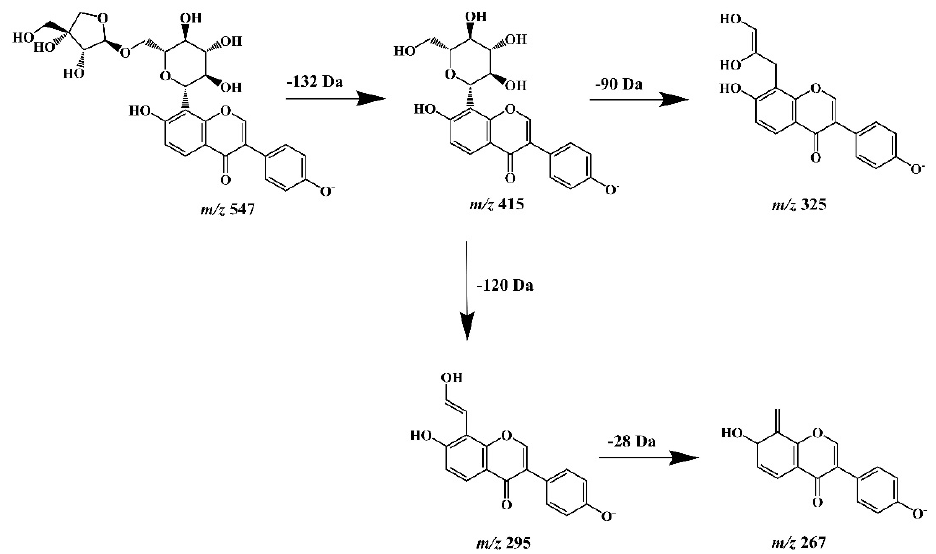
Figure 6. Hypothetical fragmentation pattern proposed to confirm the molecular structure of mirificin ( m / z 547) based on the obtained mass spectrometric data .